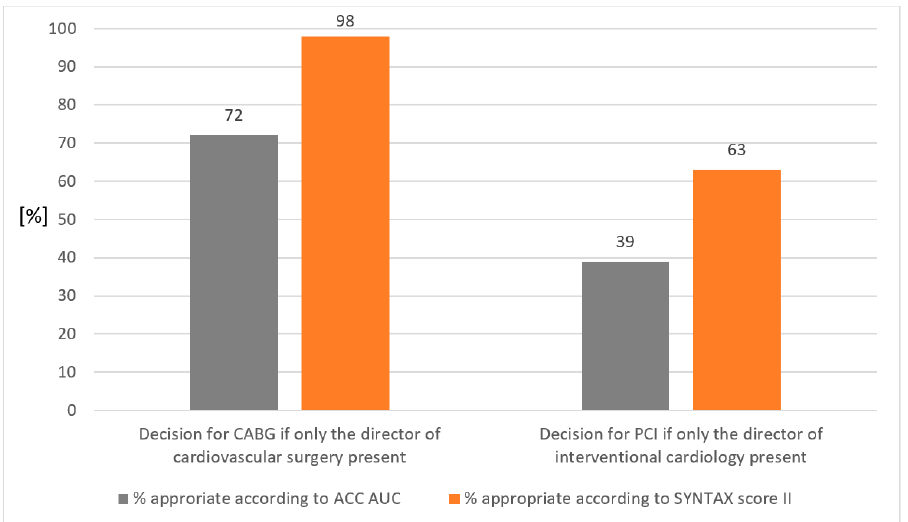
Figure 4. Appropriateness of Heart Team decisions. Legend: Bar chart of the appropriateness according to American College of Cardiology appropriate use criteria (ACC AUC: grey bar) and SYNTAX score II (yellow bar). CABG = coronary artery bypass grafting; PCI = percutaneous coronary intervention.